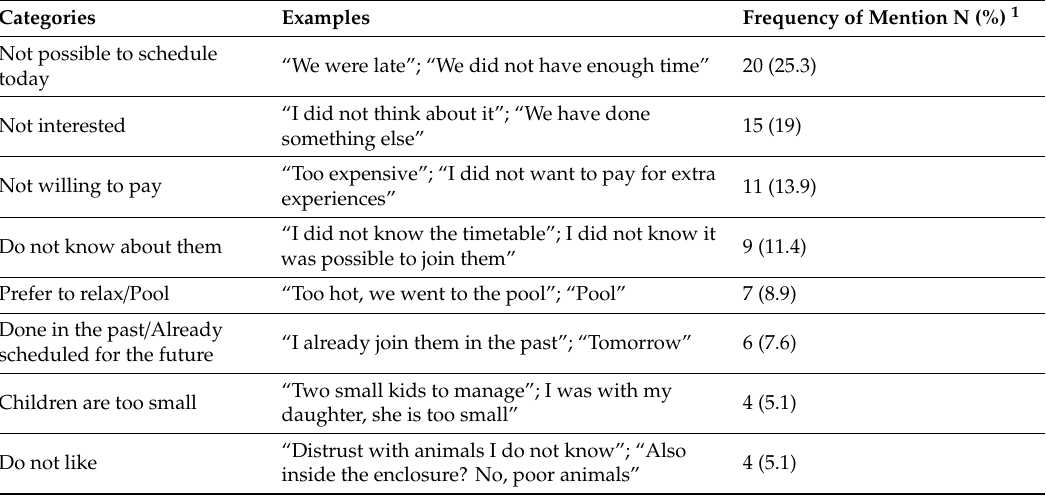
Table A10. Frequency of mention of the categories and examples of individual motivation given when respondents ( N = 79) who had not joined any animal–visitor interaction on the day of the survey were asked the reason (in order of frequency).